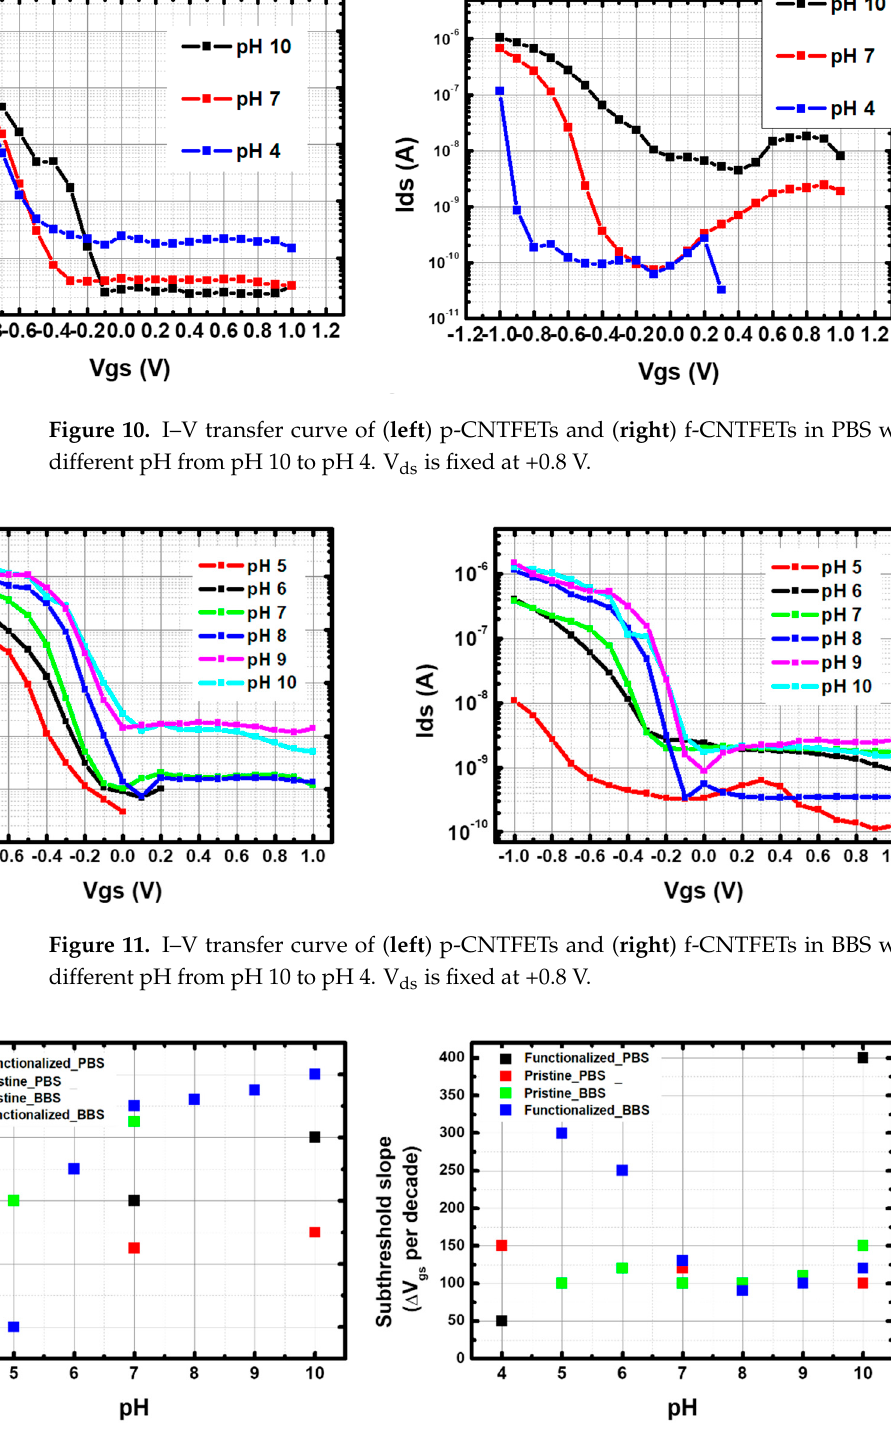
Figure 12. ( left ) V th and ( right ) Subthreshold slope of p-CNTFETs and f-CNTFETs in di ff erent bu ff er